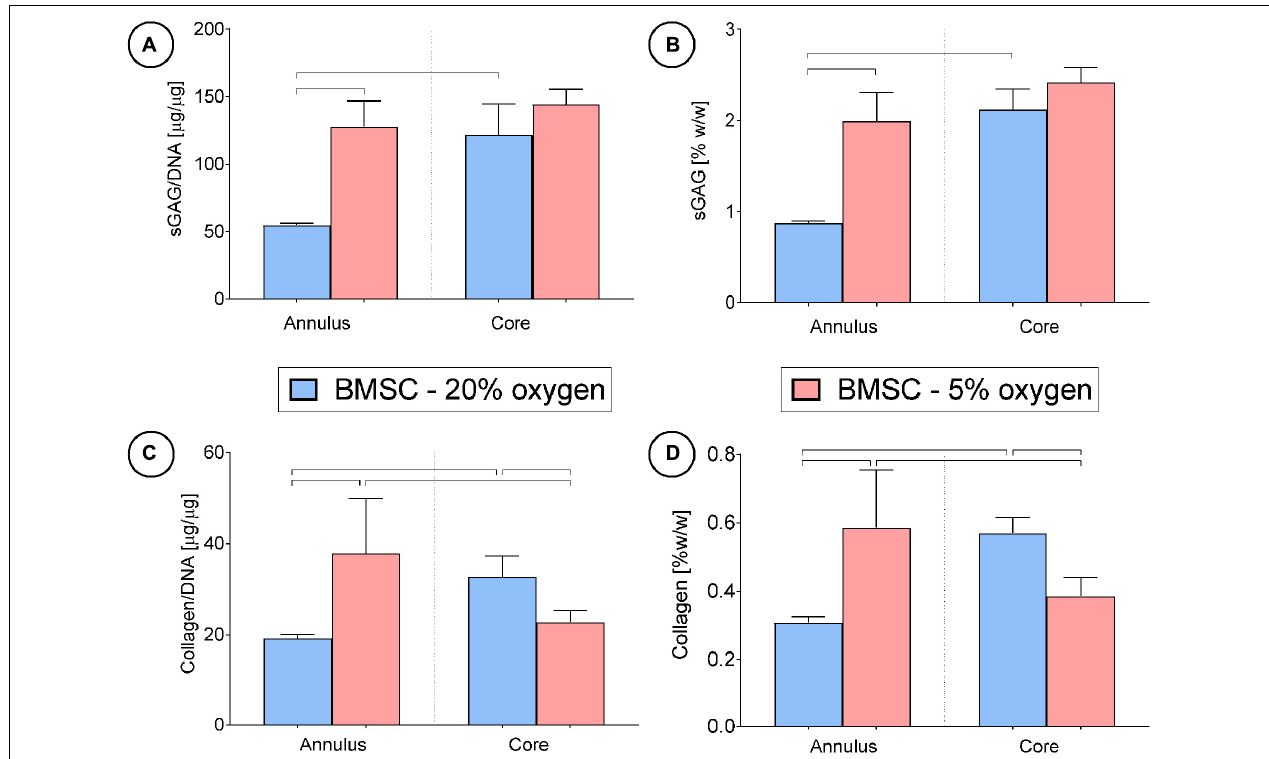
FIGURE 7 | Cartilage tissue grafts engineered using bone marrow MSCs were cultured in either a 20% or low (5%) external oxygen environment for 24 days were separated into cores and annuli, then analyzed for DNA, sGAG and collagen content. Significant differences between groups are indicated where P < 0.05 ( n =